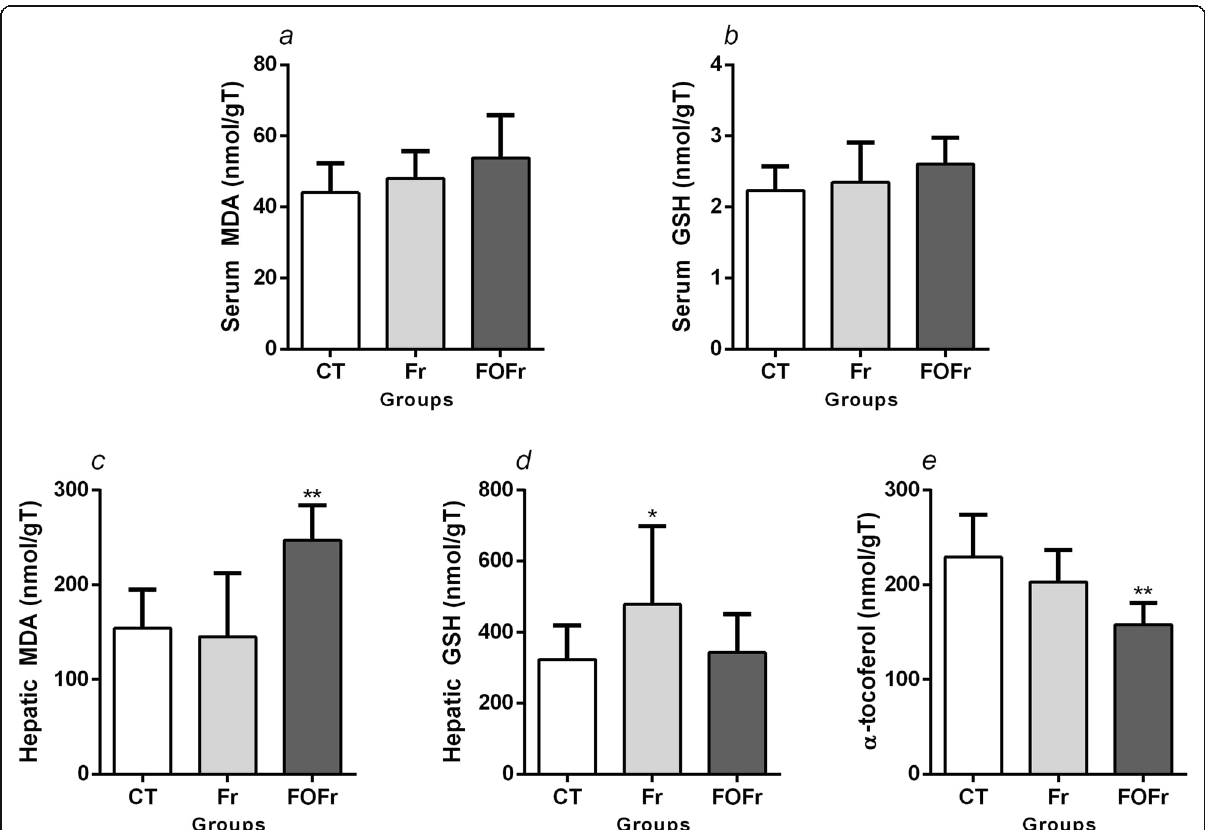
Fig. 4 Oxidative stress parameters. a Serum MDA, b serum GSH, c hepatic MDA, d hepatic GSH, and e hepatic α -tocopherol. Values are mean ± SD. Asterisk indicates a significant difference when compared to CT and FOFr. Double asterisk indicates a significant difference when compared to CT and Fr ( P <